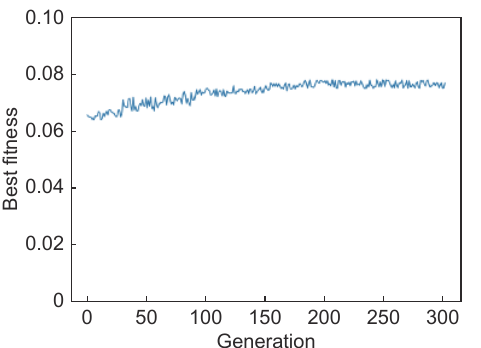
Fig. 4 Best fitness value of the hybrid algorithm in each